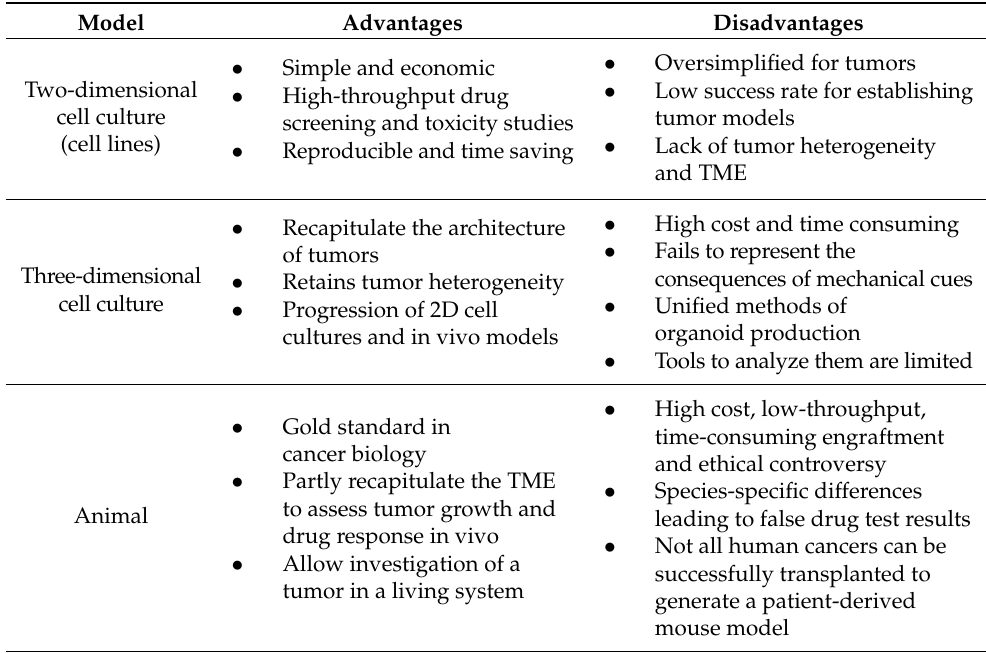
Table 1. Conventional pre-clinicals in cancer